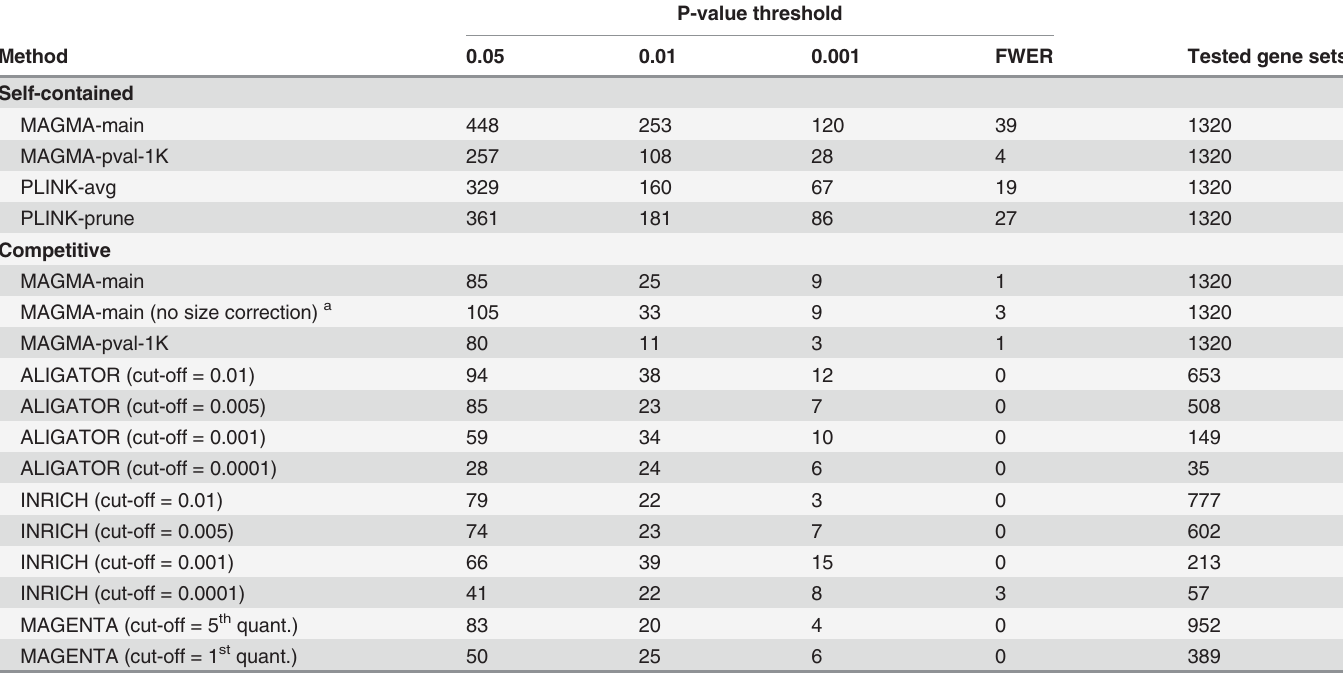
Table 3. Number of significant gene sets at different p-value